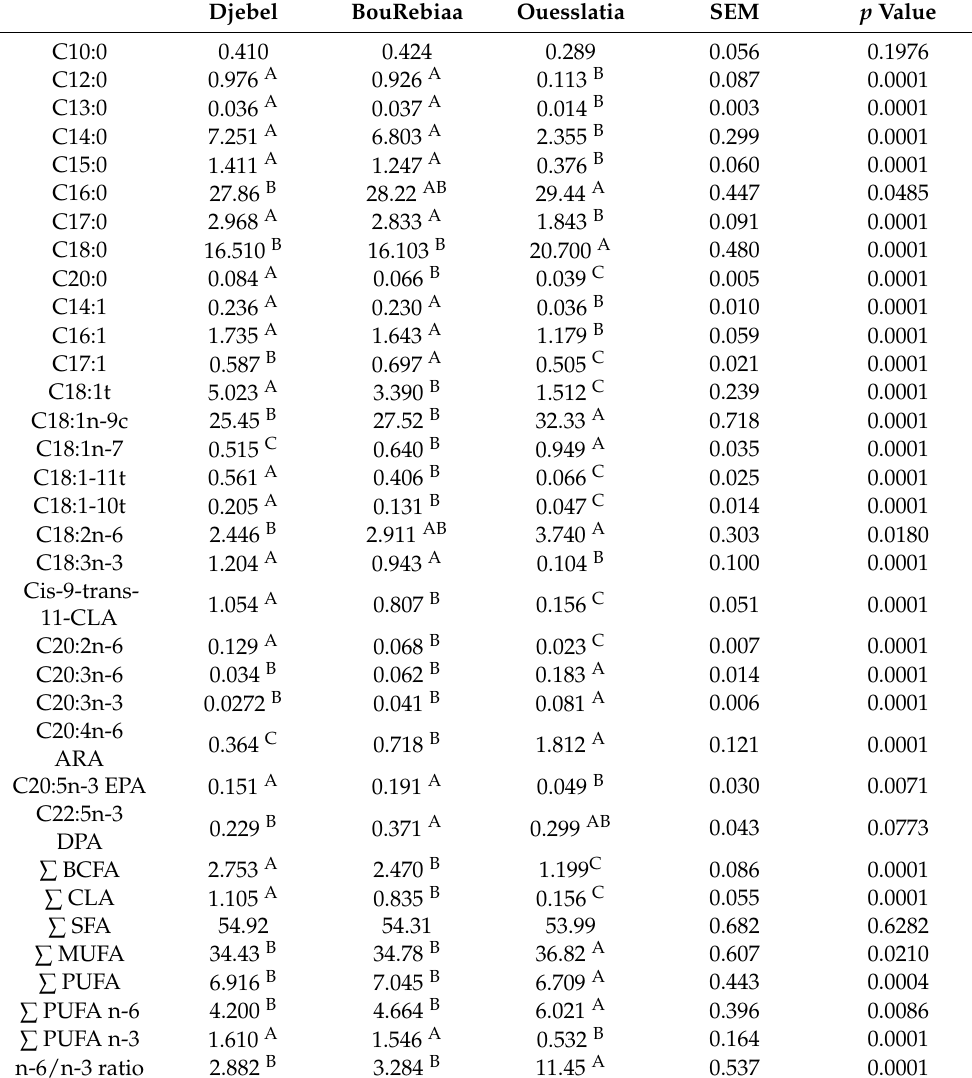
Table 1. The proportion of FAs (percentage of total FAs) in lamb meat based on the farming system. Statistically different groups ( p < 0.05), according to the ANOVA, are denoted by different letters (A, B,